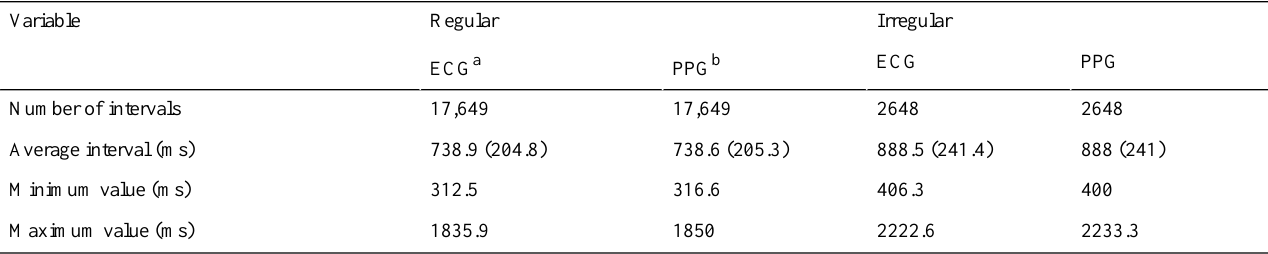
Table 7. Summary of intervals divided into regular and irregular beat-to-beats.